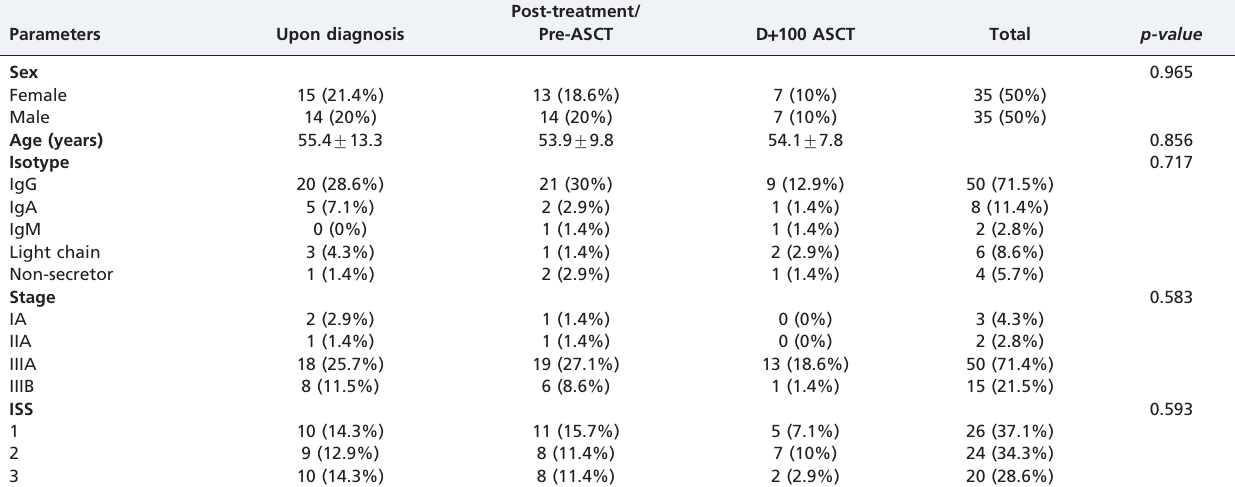
Table 1 - The clinical and laboratory characteristics of the 49 MM patients (upon diagnosis, post-treatment/pre-ASCT, and D + 100 ASCT). Total of 70 interviews.